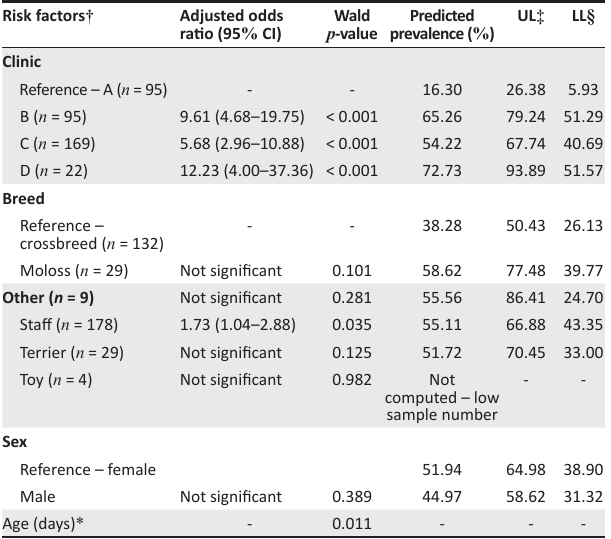
TABLE 1: Prevalence and risk factors of Campylobacter spp. according to clinic, breed, sex and age. Risk factors † Adjusted odds